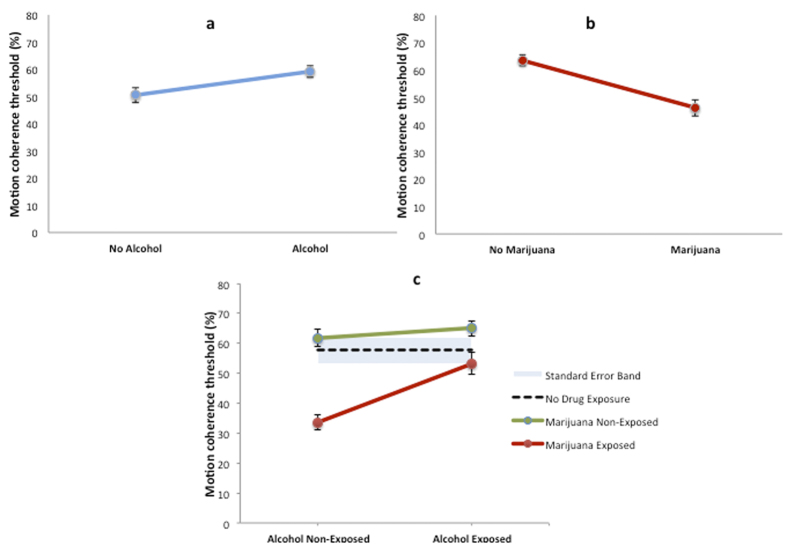
The effect of prenatal exposure to alcohol, marijuana and their combination on motion coherence thresholds, a measure of global motion perception.(a) Prenatal alcohol exposure (n = 95) impaired global motion perception (b) Prenatal marijuana exposure (n = 67) improved global motion perception (c) Exposure to marijuana in the absence of alcohol (n = 20) was associated with a substantial improvement in global motion perception that was significantly better (p < 0.001) than children with no history of drug exposure (dotted line, n = 25). Error bars and the shaded area show standard error of the mean.